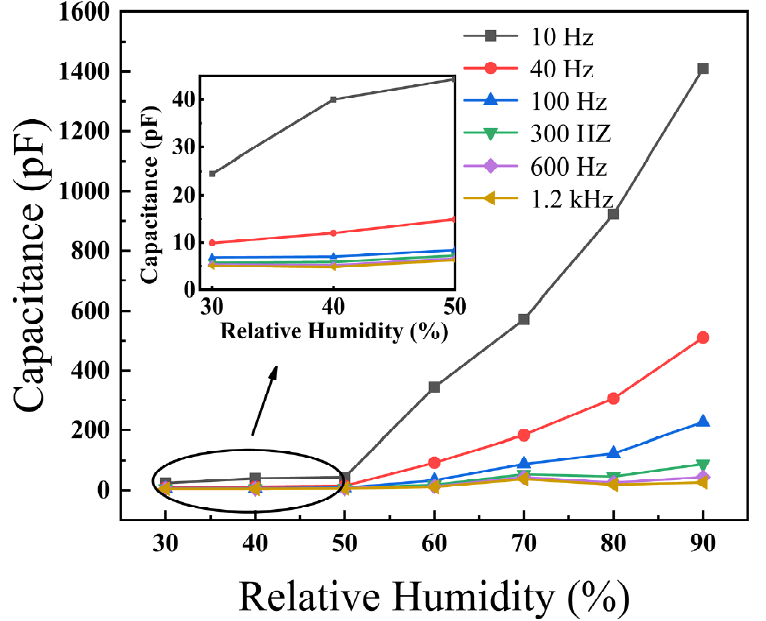
Figure 3. RH dependence on the capacitance of BiFeO 3 film. Inset: enlarged capacitance vs. %RH plot (30 – 50% RH range).